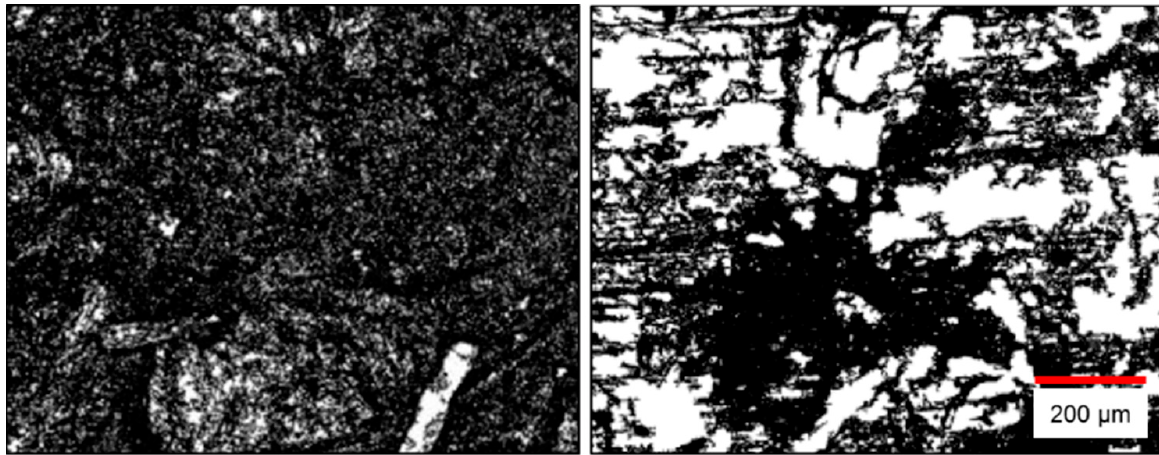
Figure 9. Microscopy images of the surface structure of a GCI brake pad; left: unused condition; right: after 10 × trip #10 of the WLTP brake cycle.